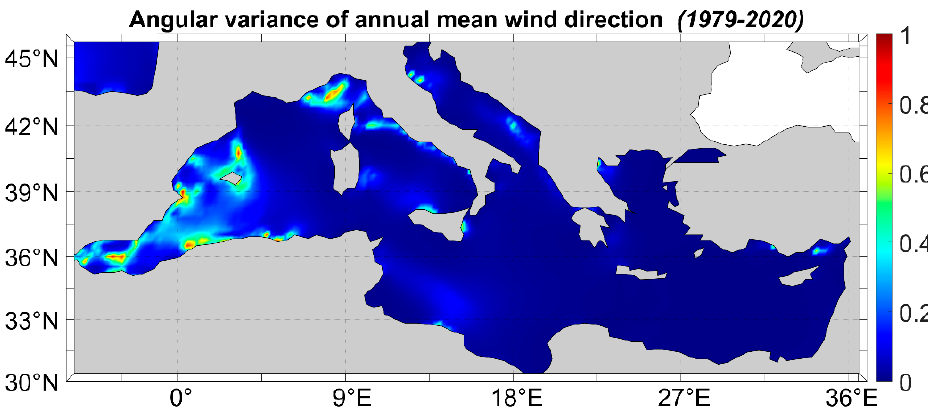
Figure 5. Angular variance of annual mean wind direction.